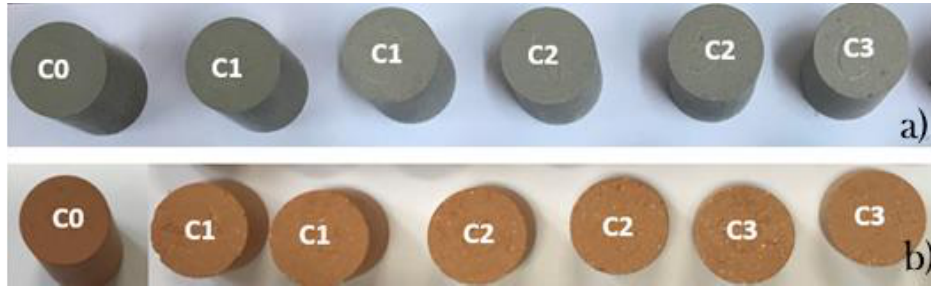
Figure 2. Green ( a ) and fired samples ( b ).